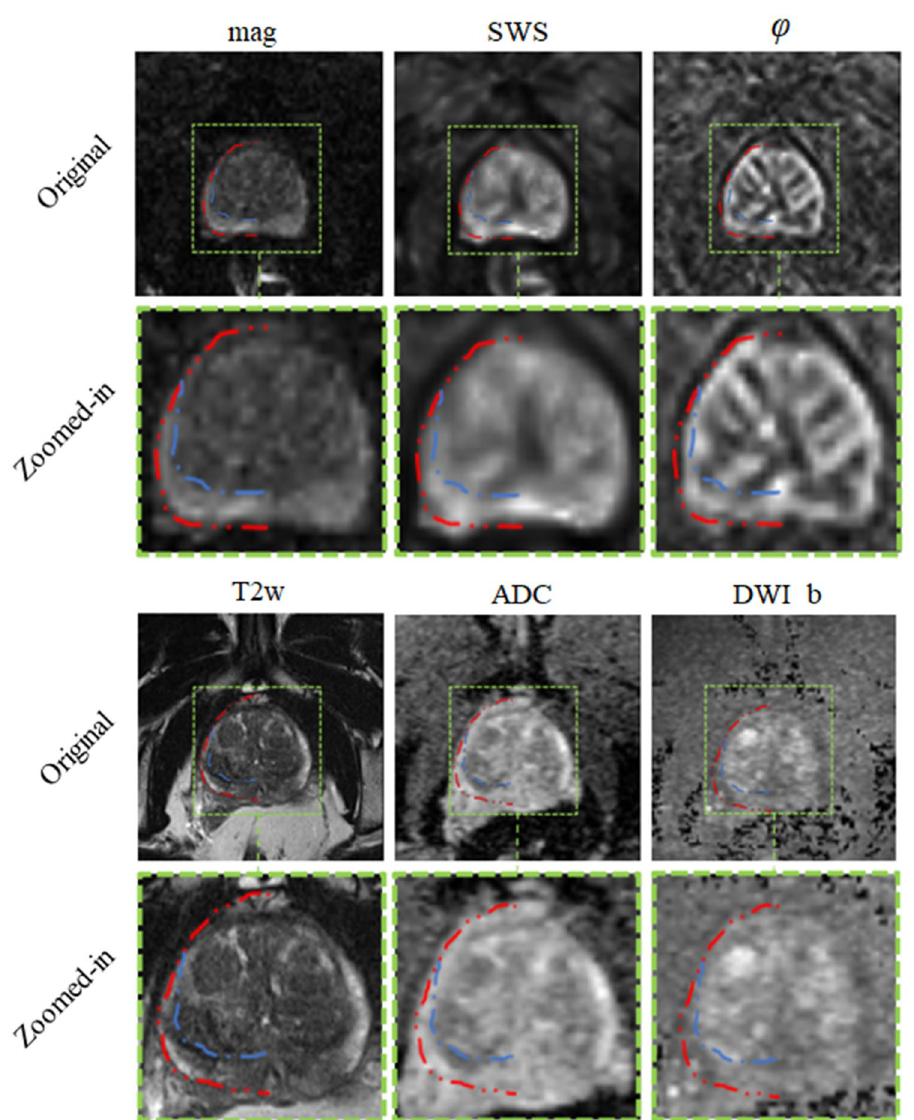
Figure 9. Different maps of the same patient. Second and forth rows show zoomed-in images of the first and third rows, respectively. Dotted red and blue lines highlight part of the segmentation for prostate and PZ, respectively and the rest of the delineation was omitted to show the actual pixel